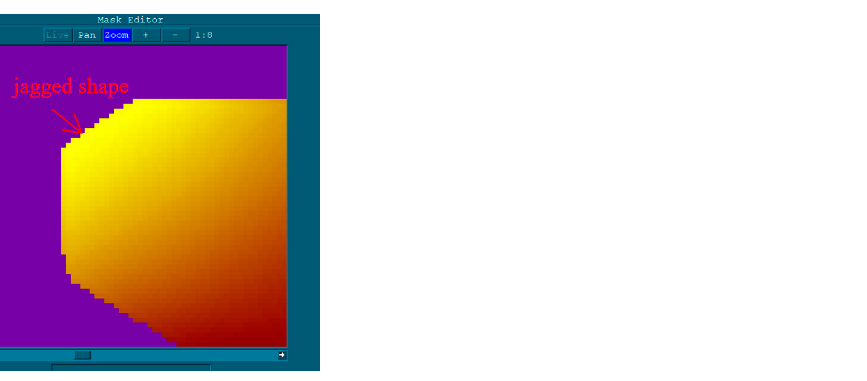
Figure 11. 24 inch interferometer measurement results (resolution 0.00066 m).